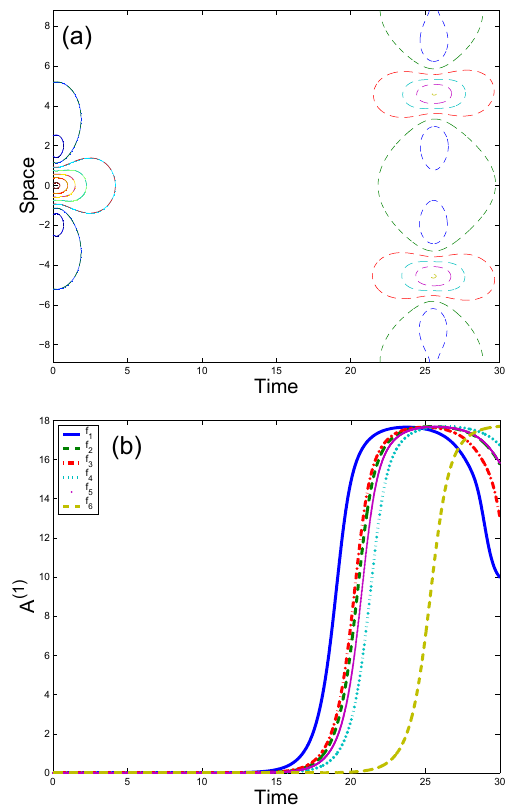
Figure 5. (a) Contours of | U (cid:15) (x,t) | (dashed line) and the one-mode SPB | U ( 1 ) (x,t ; ρ ∗ ) | (solid line) over a plane wave with two UMs. (t) for each f i . (b) Evolution of A ( 1 ) i